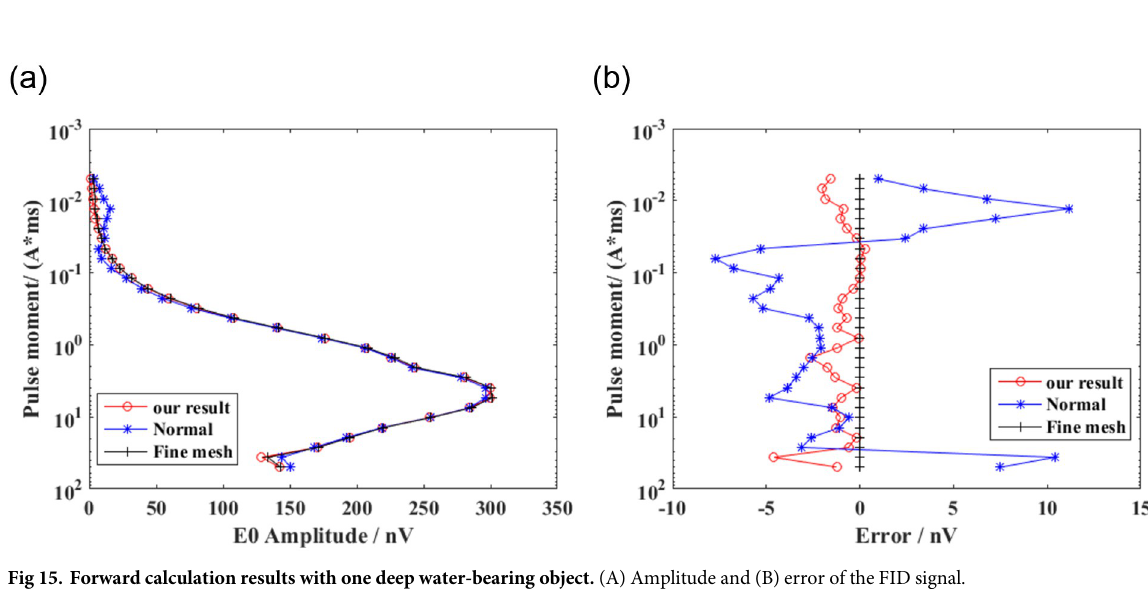
Fig 14. Forward calculation results with one shallow water-bearing object. (A) Amplitude and (B) error of the FID signal.